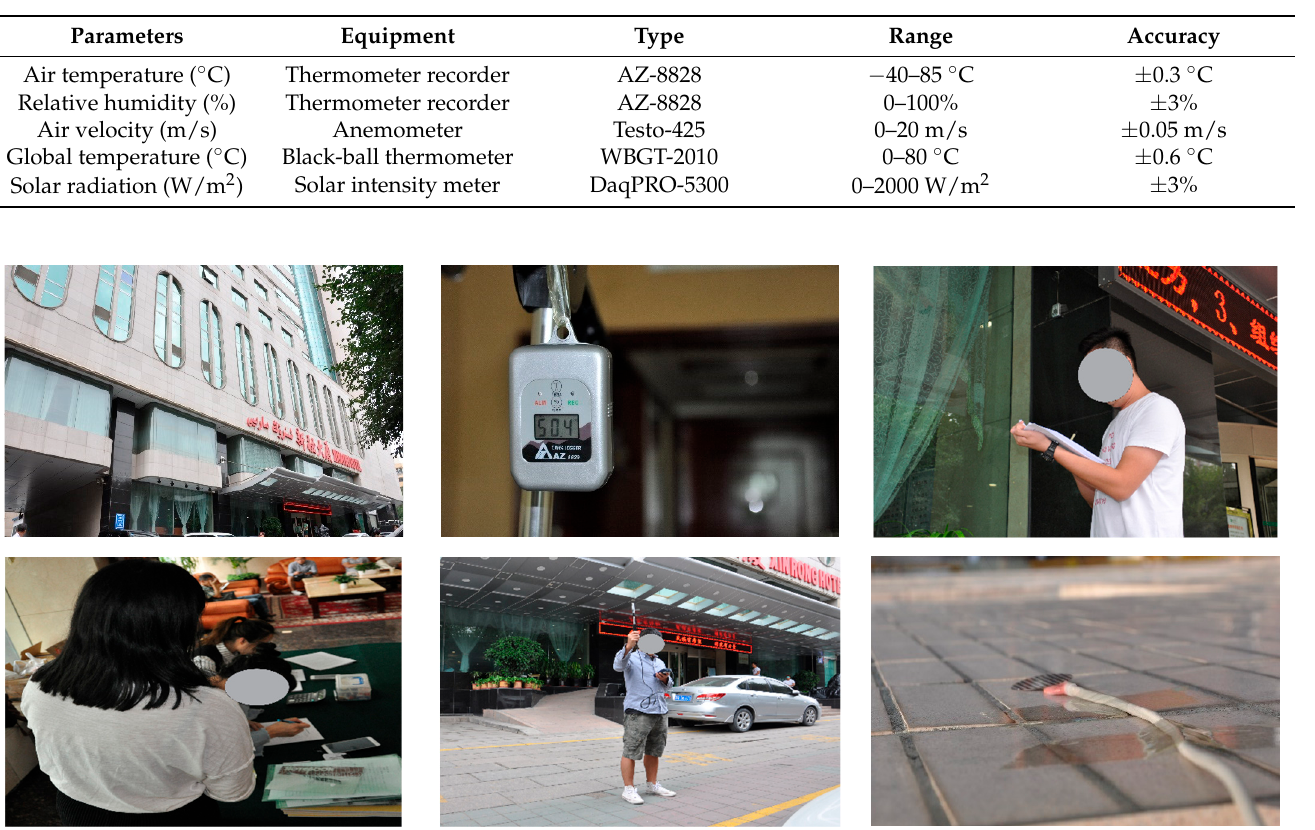
Figure 3. Photographs of the field investigation process. Table 5. The detail parameters of test